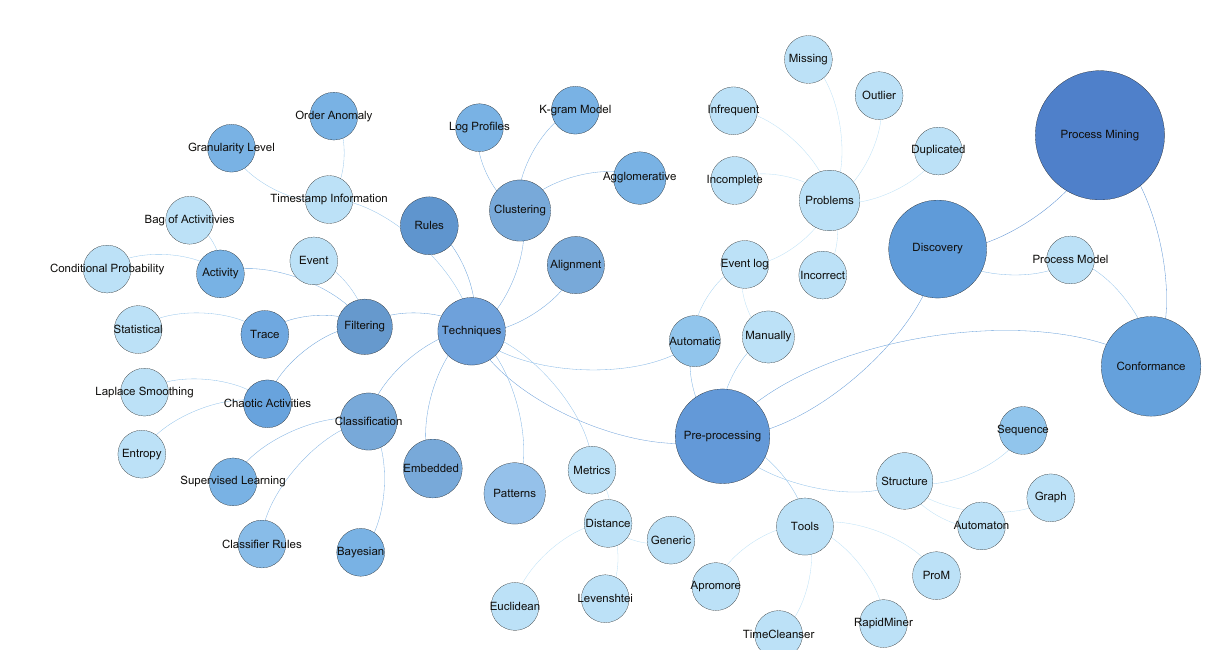
Figure 5. Summary of different closely related terms and their relations in the data preprocessing domain in process mining.